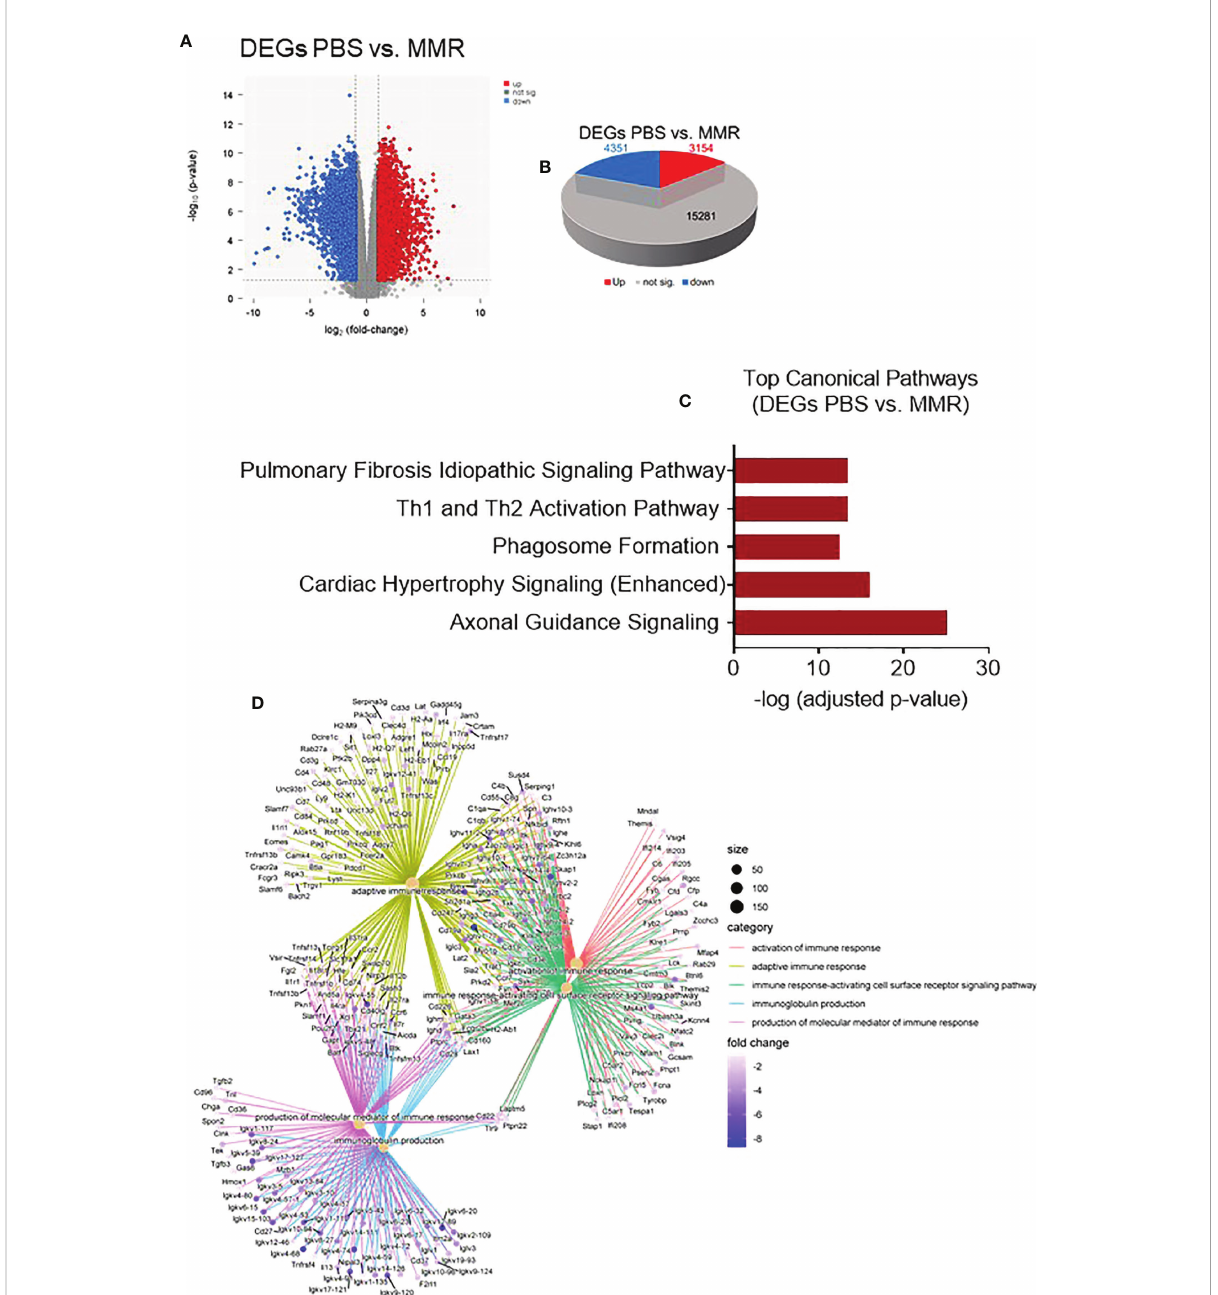
FIGURE 3 Transcriptomic analysis of Hepa 1-6 tumors treated with the MMR vaccine. (A) Volcano plot of mRNA expression differences for PBS vs. MMR. (B) 3-D Pie slices of the numbers of differentially expressed genes (DEGs) in PBS vs. MMR groups. DEGs were determined using the limma- voom method. A fold-change |logFC| ≥ 1 and false discovery rate (FDR) of 0.055 were used as a cutoff. The logFC was computed using the difference of the mean of log2(MMR) and mean of log2(PBS), that is, mean of log2(MMR) - mean of log2(PBS). (C) Graph showing top-scoring canonical pathways signi fi cantly enriched by treatment with MMR compared to PBS. (D) Gene ontology (GO) analysis using gseGO. Visualization of Gene Set Enrichment Analysis (GSEA) on the DEG between PBS controls and MMR